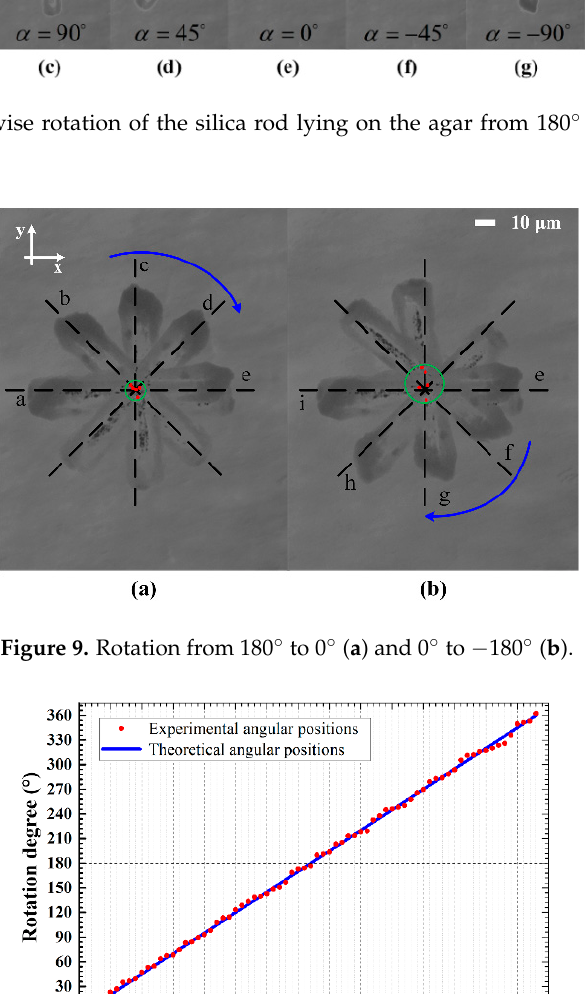
Figure 10. Rotation with 5° angle interval.